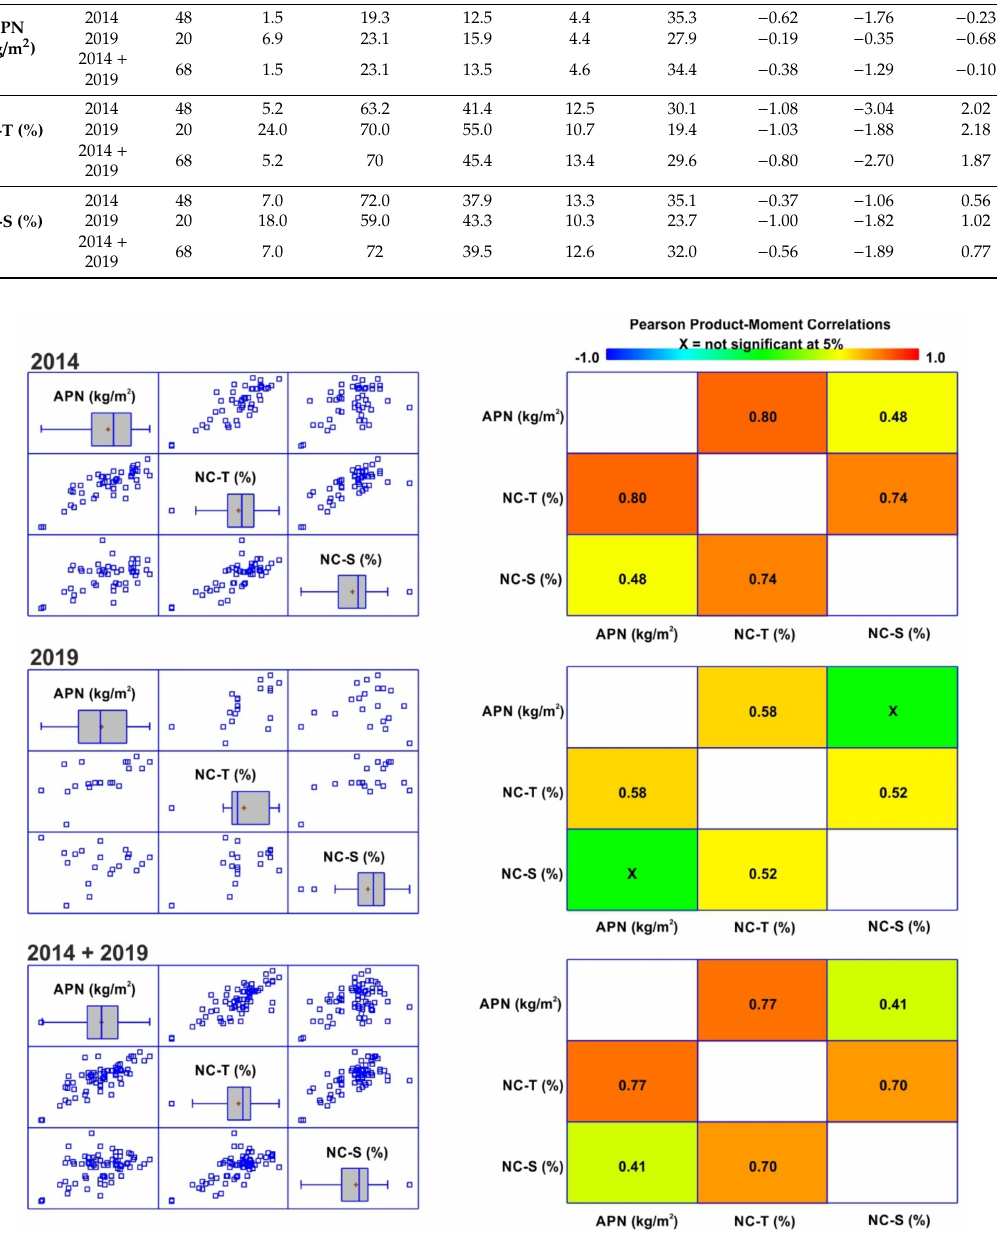
Figure 3. Graphs of linear correlation coe ffi cients between nodule abundance (APN), nodule coverage of grid photo (NC-T), and seafloor